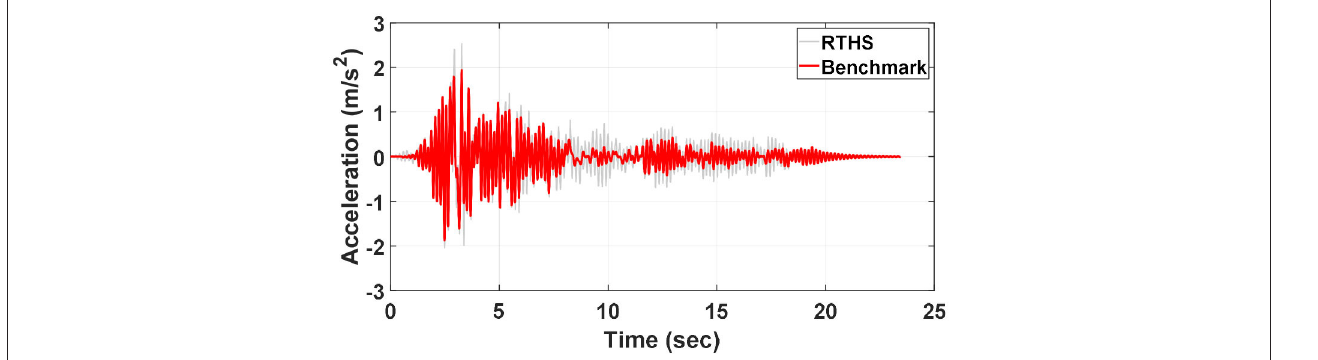
FIGURE 13 | Acceleration time histories of the superstructure from RTHS and